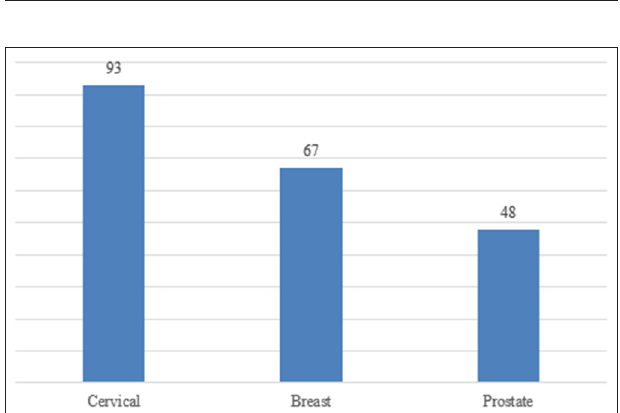
FIGURE 5 | Figure showing the distribution of studies on breast, cervical and prostate cancer in Sub-Saharan Africa (some studies included more than one type of